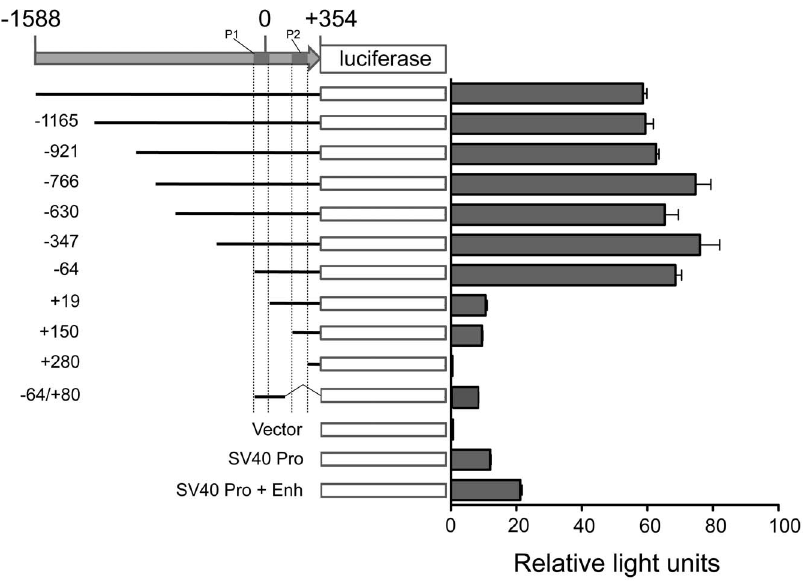
Figure 1. Reporter assay analysis of a 2 kb Mina promoter fragment. The transcriptional start site (TSS), labeled 0, is from NCBI (NM_025910.3). Internal control plasmid pRL-TK encoding renilla luciferase was cotransfected with each firefly luciferase construct. Parental (light gray filled arrow) and nested deletion constructs are diagrammed to the left of the bar graph with numbers representing the 5 9 (and in the case of 2 64/ + 80, the 3 9 ) termini of each construct. The inferred positions of P1 and P2 are labeled and depicted as dark gray rectangles. Vector is PGL3 basic vector; SV40 pro is PGL3 basic vector containing the SV40 promoter; and SV40 pro + enh is PGL3 basic vector containing the SV40 promoter and enhancer elements. Data are expressed as relative light units (the ratio of firefly to renilla luciferase activity) and presented as the mean and SEM of three independent experiments.